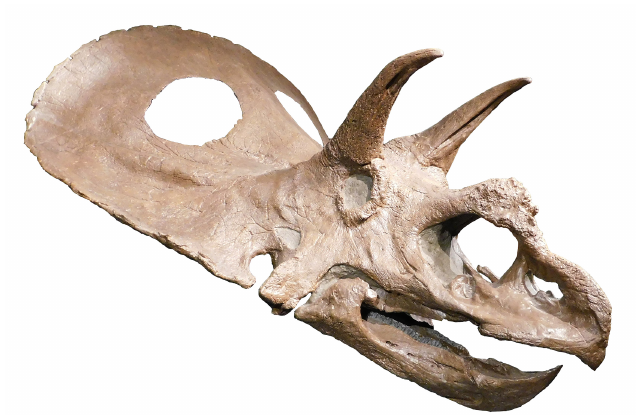
Figure 2. Cast of MOR 1122 skull which was found associ - ated with MOR 1122 7-22-00-1. This cast incorporates partial reconstruction of the rostrum (see Farke 2007) and lower jaws of another individual (AMNH FARB 5039). Specimen has a basal skull length of 126.4